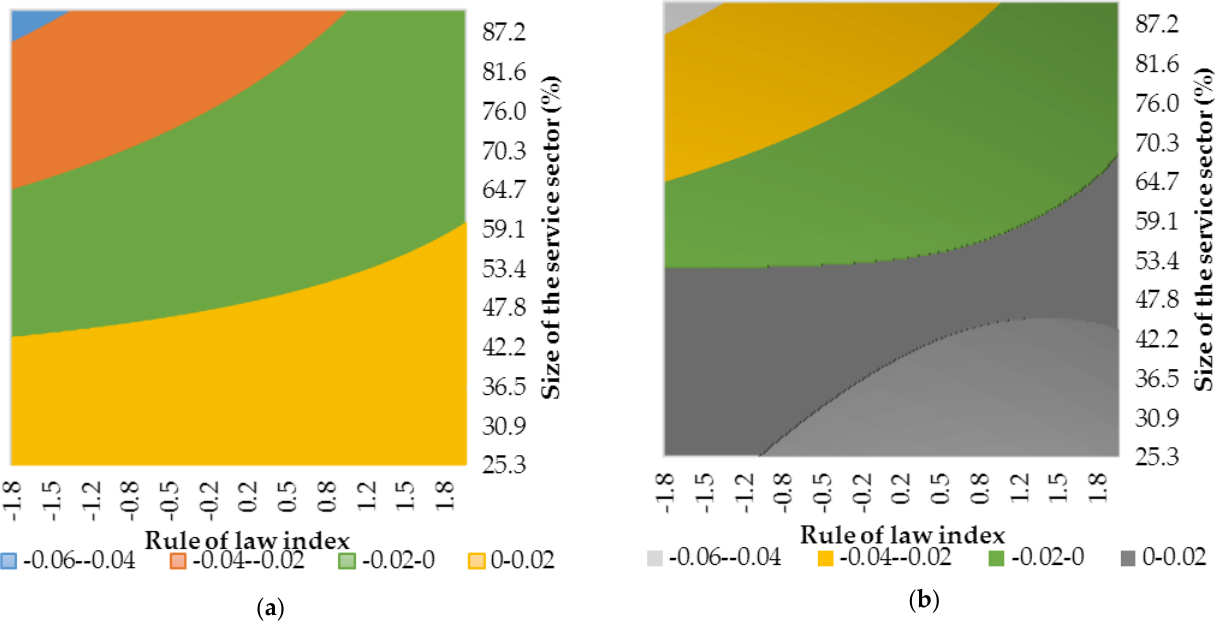
Figure A17. Conditional effect of financialisation on growth based on Est. 17 in Table A2. ( a ) Estimated conditional slope coefficient over the whole range of observed values for institutional quality and development level. ( b ) Estimated statistically significant conditional slope coefficient. Dark gray represents a combination of institutional quality and development level for which effect of financialisation on growth is statistically insignificant. Source: authors’ contributions.